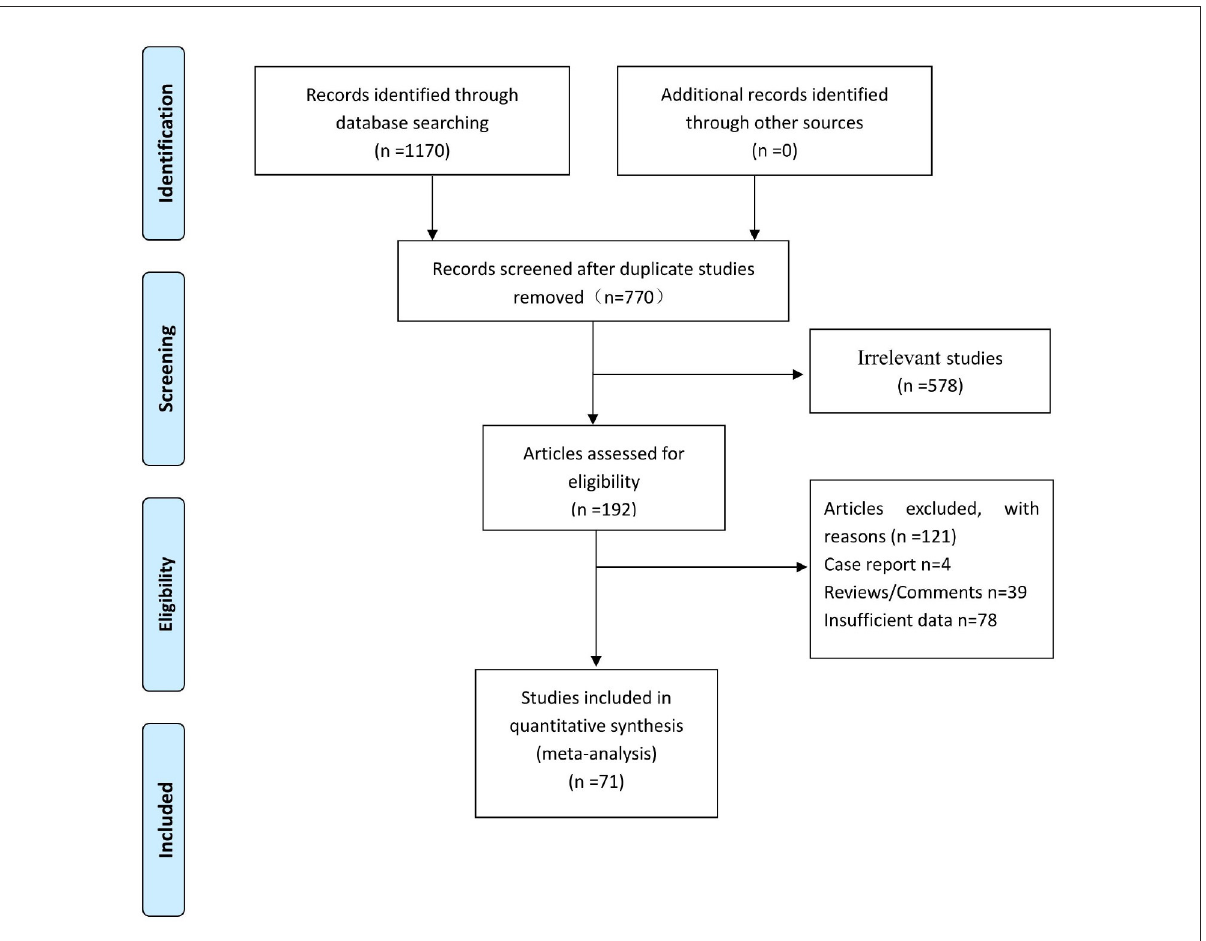
FIGURE1 Flow diagram of study